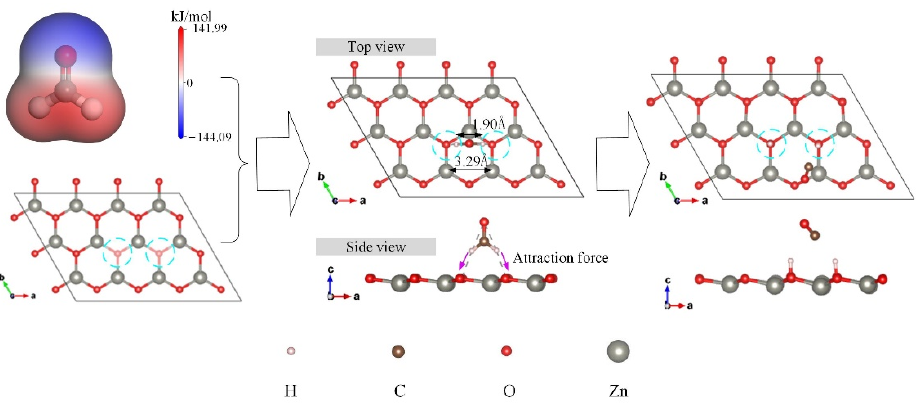
Figure 6. Schematic view of CH 2 O adsorption and decomposition on the surface of ZnO(0001)